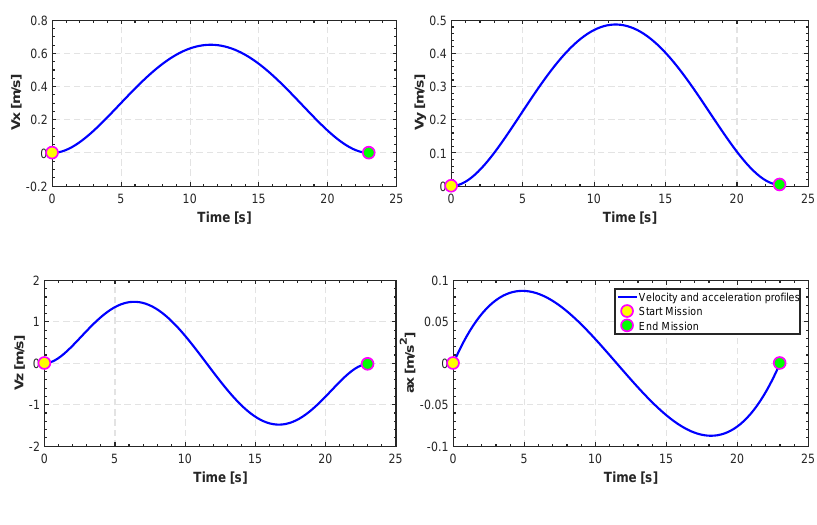
Figure 15. Translation of velocities and acceleration for